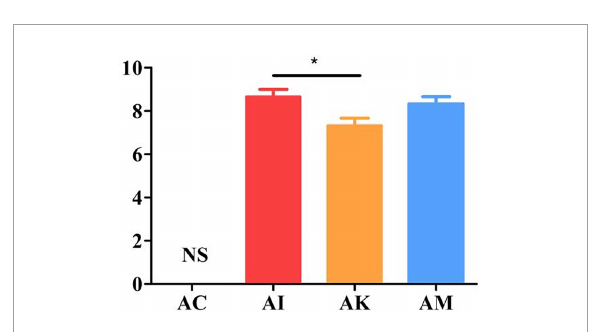
FIGURE2 The SHIRPA scores of mice with acute T. gondii infection at 6 dpi. The control group (AC) was regarded as having no changes in the clinical score. AC: no T. gondii + PBS; AI: 50 T. gondii cysts + PBS; AK: 50 T. gondii cysts + koumiss; AM: